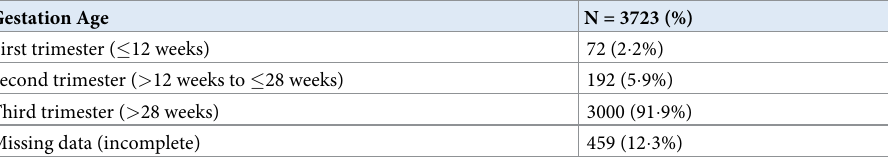
Table 1. Distribution of gestation age among